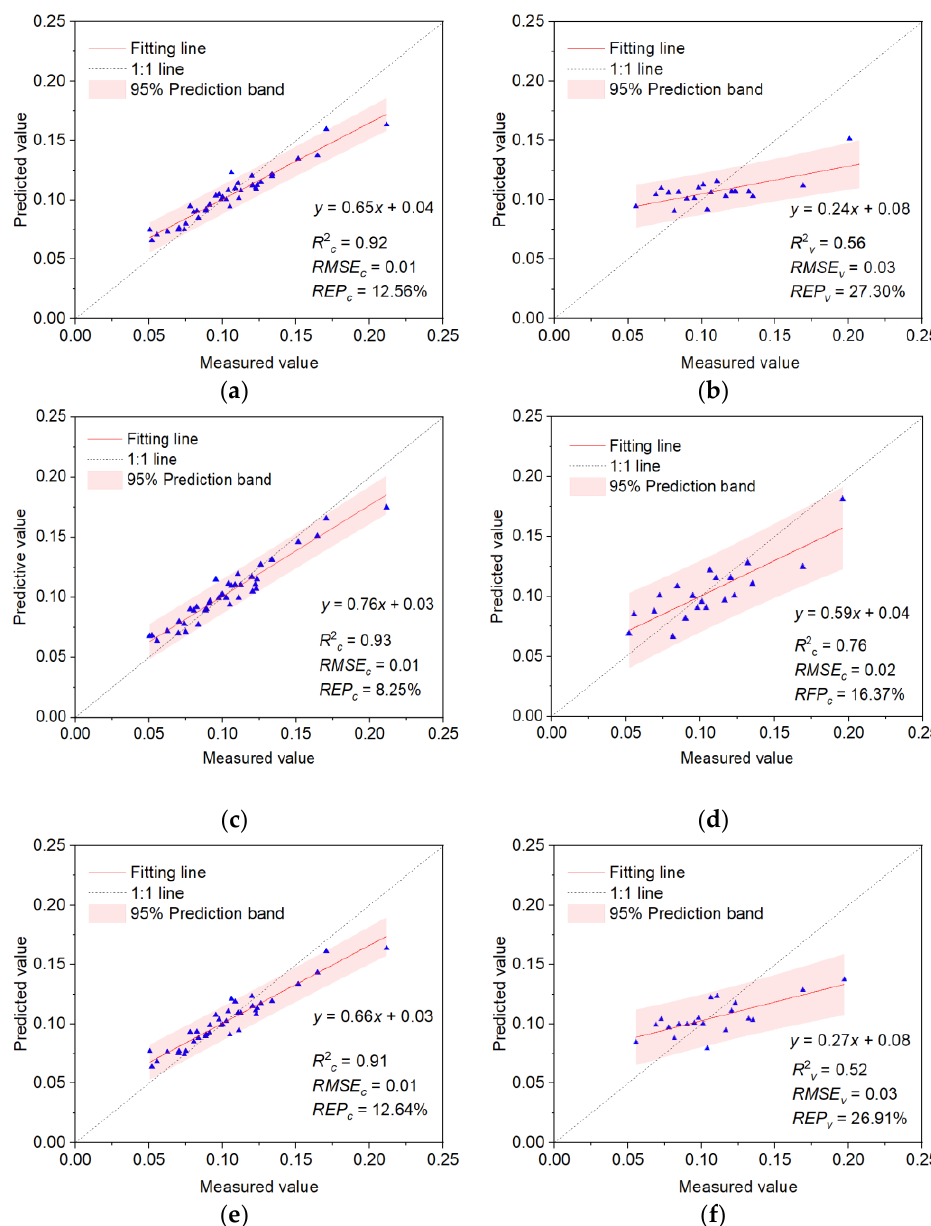
Figure 7. Distribution of measured Anth and predicted Anth in the random forest (RF) models: ( a , b ) are the calibration set and test set of the RF model based on principal component analysis using an unmanned aerial vehicle (PCA + UAV); ( c , d ) are the calibration set and test set of the RF model based on first-order differential using an unmanned aerial vehicle (FD + UAV); ( e , f ) are the calibration set and test set of the RF model based on continuum removal using an unmanned aerial vehicle (CR +